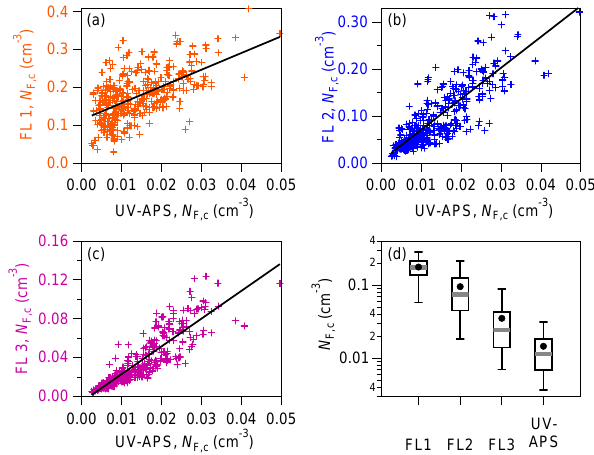
Figure 4. Comparison of coarse (>1µm) fluorescent particle num- ber ( N F , c ) between individual WIBS channels and UV-APS shown for entire measurement period. Colored crosses show individual 5min data (a–c) , and black diagonal lines show unweighted lin- ear fits. Correlation coefficients are FL1, R 2 0.34 (a) ; FL2, R 2 0.68 (b) ; and FL3, R 2 0.78 (c) . Statistical overview of all data shown for each channel as box-and-whisker plots (d) , where the black dot is the mean, horizontal gray bar the median, black box the 25–75th percentile, and vertical bars the 5–95th percentiles. Vertical scales are different in each correlation plot (a–c)